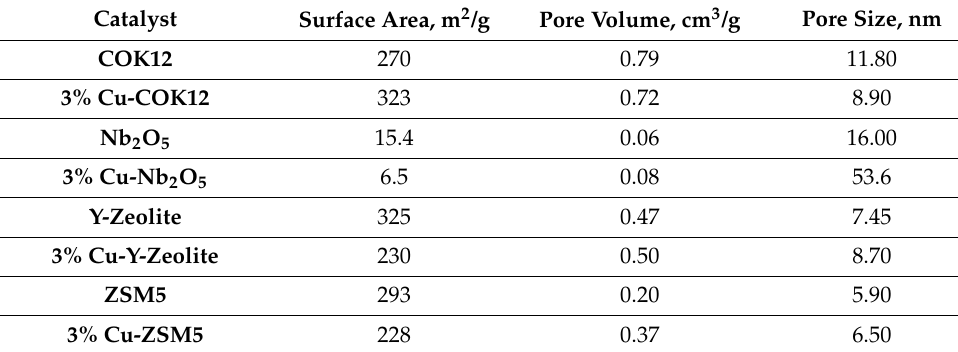
Table 1. Surface Area measurement of all the catalysts used in the research.